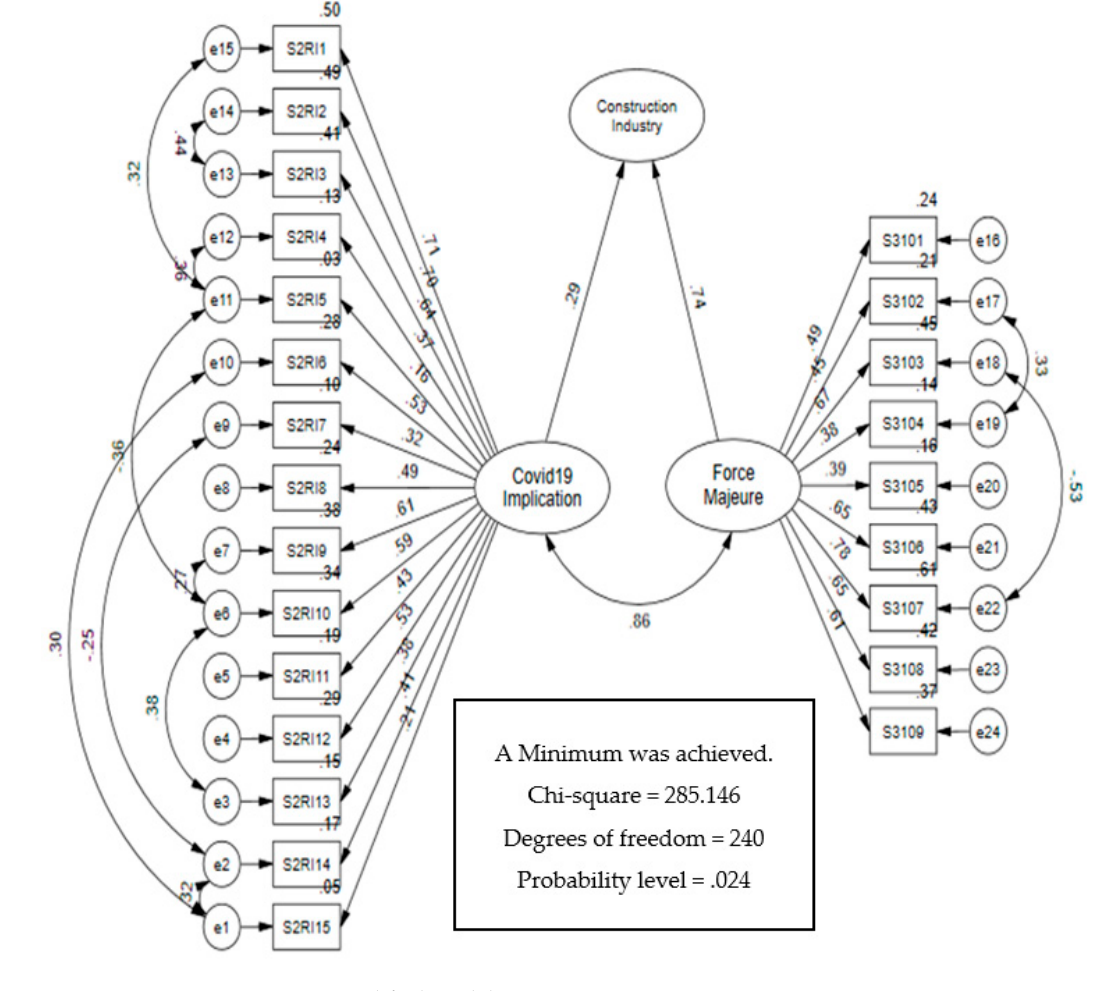
Figure 5. Modified model. Table 8. Showing the output for unfit model and modified